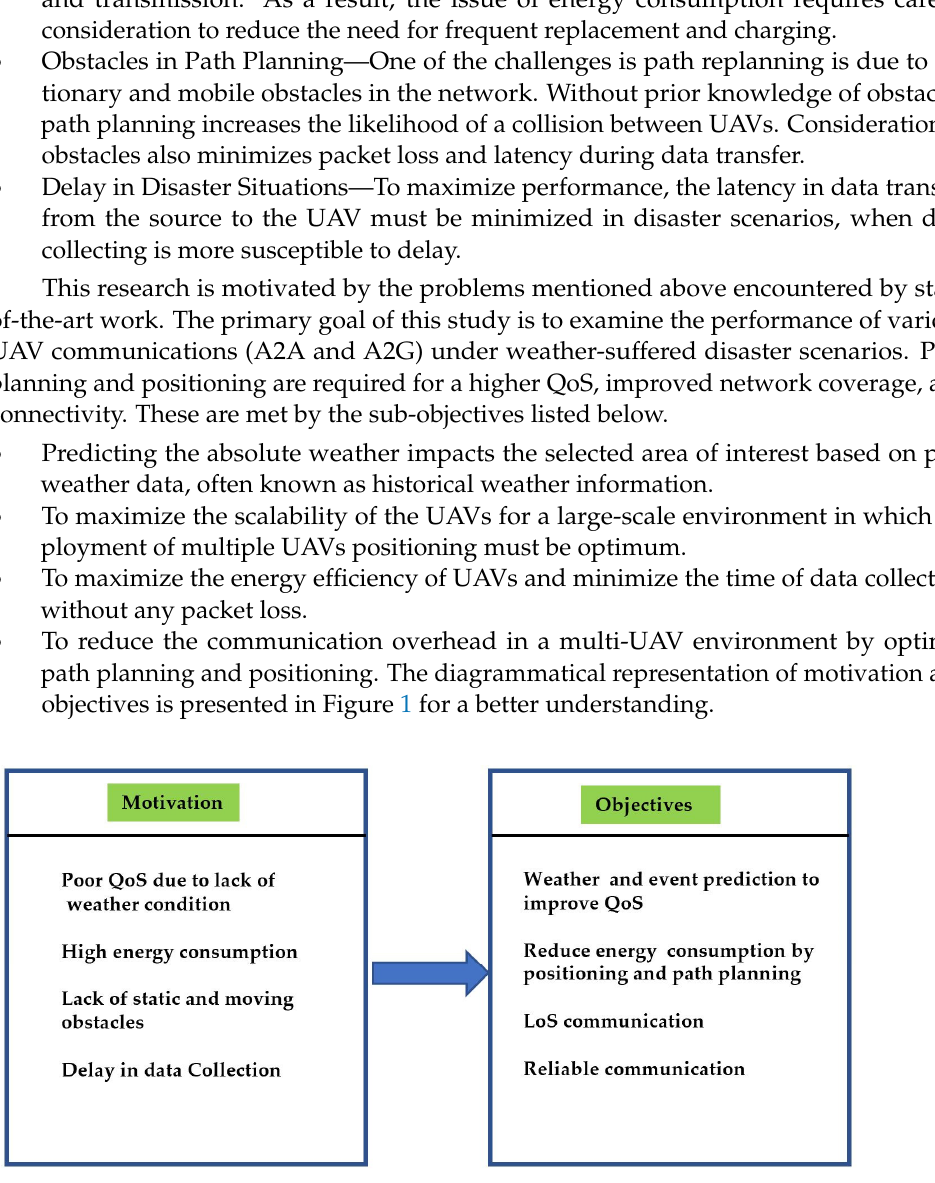
Figure 1. Motivation and objectives.